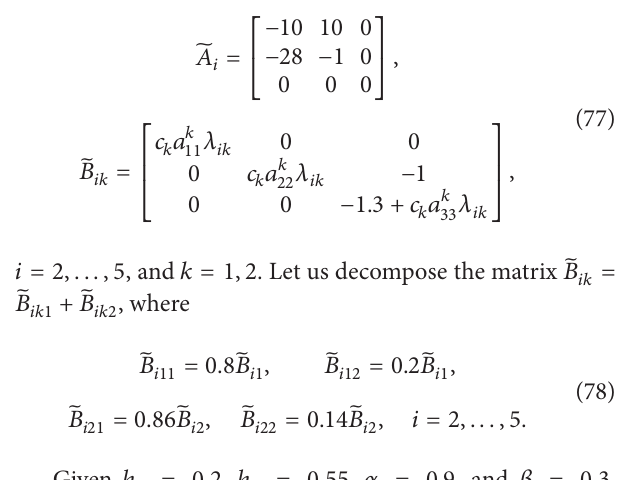
Figure 5: Synchronization state curves for the switched delay network (69).